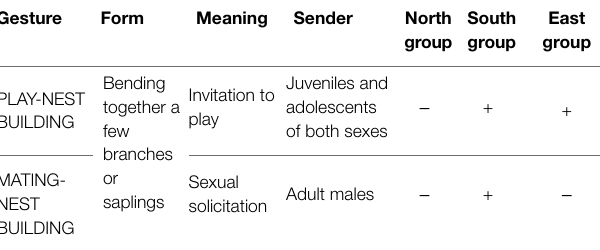
South group group